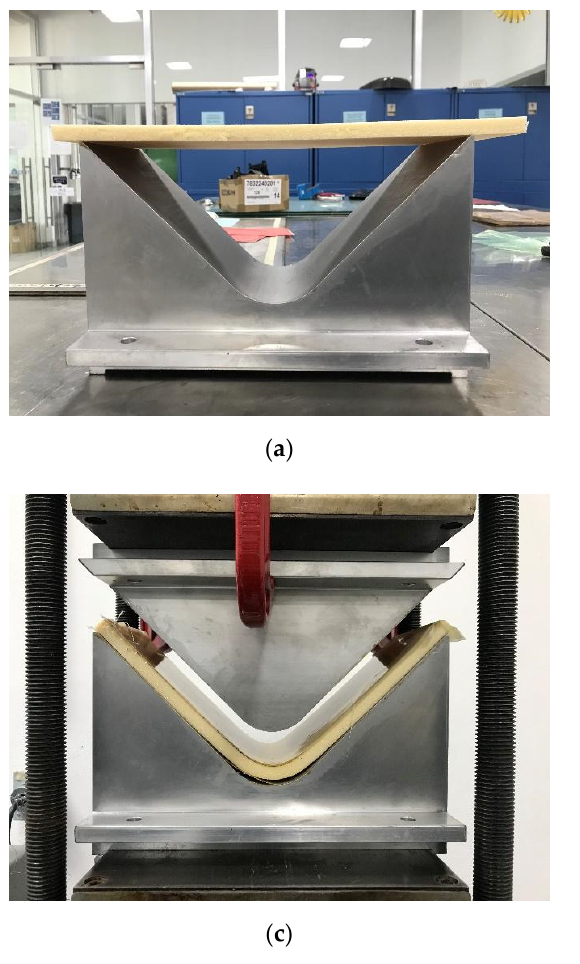
Figure 4. Schematic representation of the V ‐ shaped mold to produce the foam sandwich panels: ( a ) Unbending foam specimen, ( b ) foam specimen adapted to the V ‐ shaped mold, ( c ) preheated process, and ( d ) manufacturing of V ‐ shaped foam panel.